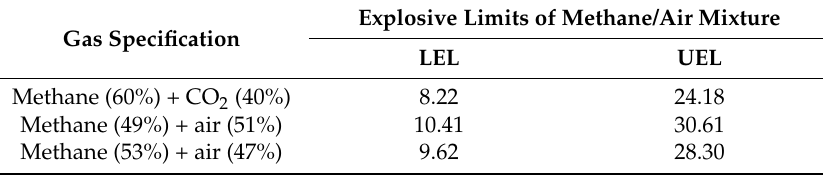
Table 2. Explosive limits of several kinds of gas mixture.